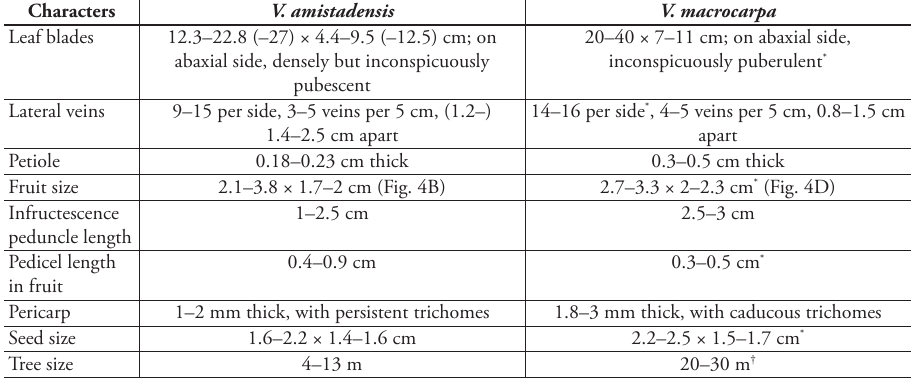
Table 4. Comparison of Virola amistadensis with the morphologically most similar species.